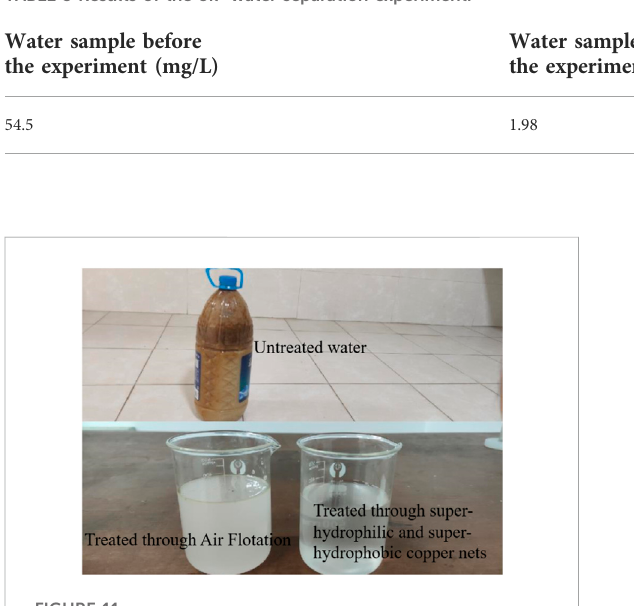
(Table 5). Through the treatment using a 500-mesh super- hydrophilic copper net, a good oil removal effect was achieved at a reasonable oil – water fl ow velocity, and the content of animal and vegetable oils was reduced to 1.98 mg/L, with the oil removal rate reaching 96.4%, which was approximate to the numerical simulation result. The water qualities before and after the treatment were compared as shown in Figure 11.